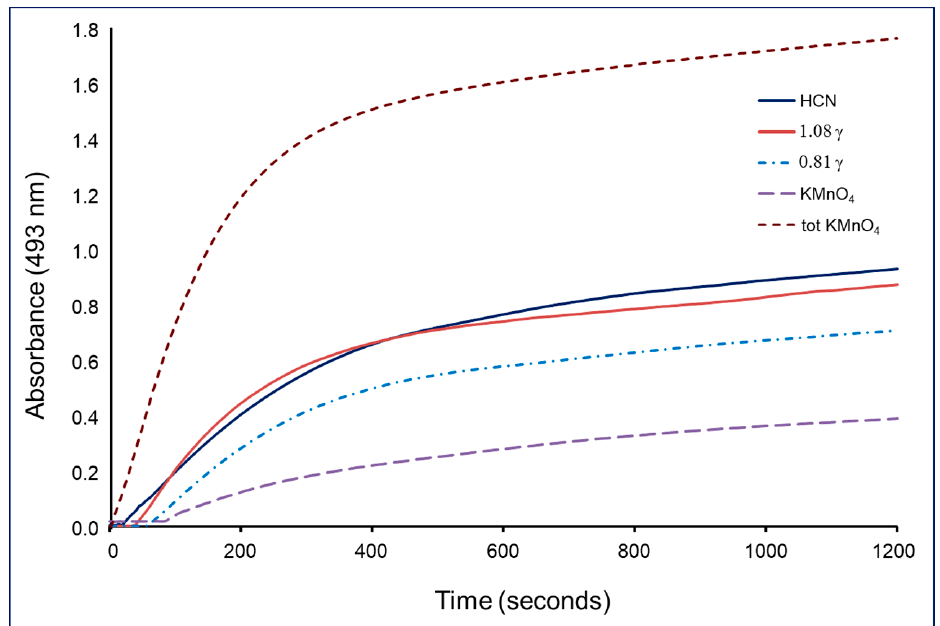
Figure 3. Kinetics of the reaction of cyanide with the ninhydrin reagent. Here, HCN—hydrogen cyanide removed first from blood with phosphoric acid; KMnO 4 —hydrogen cyanide resulting from the oxidation of thiocyanates in blood with potassium permanganate; tot KMnO 4 —total HCN resulting from one step treatment of 1 mL blood sample with potassium permanganate and phosphoric acid; 1.08 γ —1.08 µ g × mL − 1 KCN control solution; 0.81 γ —0.81 µ g × mL − 1 KCN control